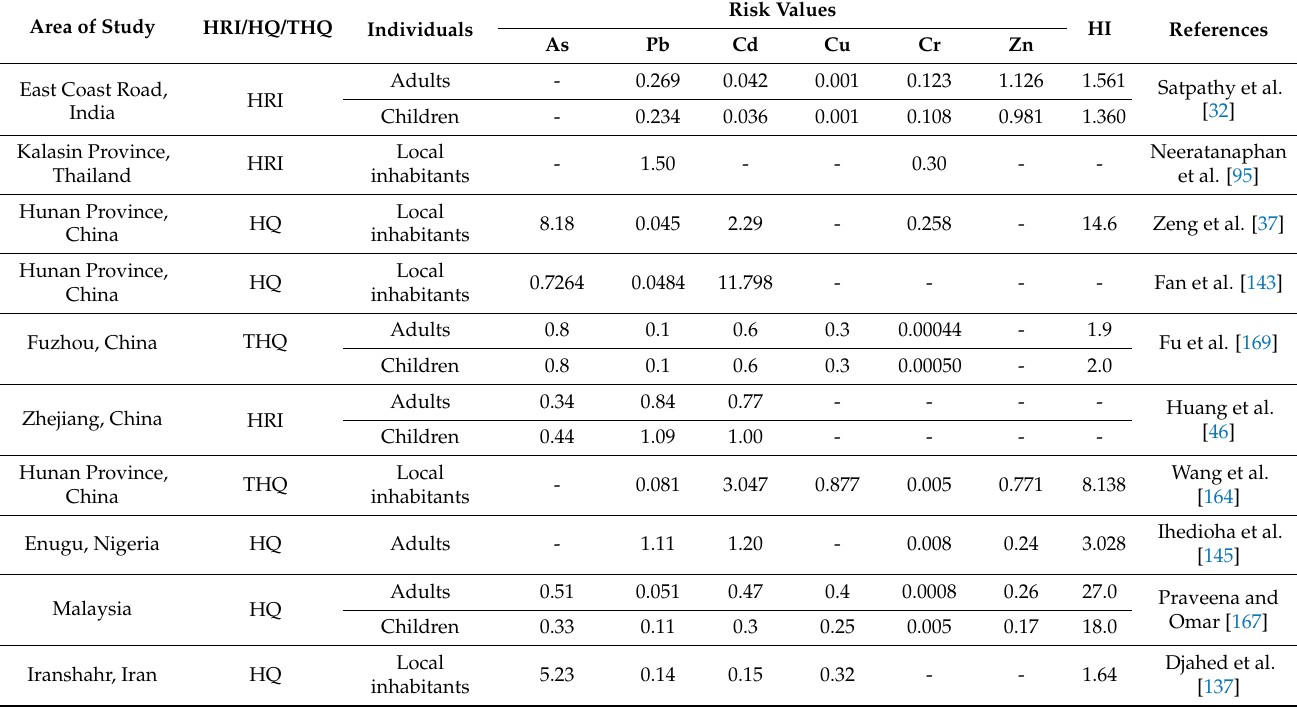
Table 5. Non-carcinogenic risk assessment from rice consumption in selected areas of different countries. Area of